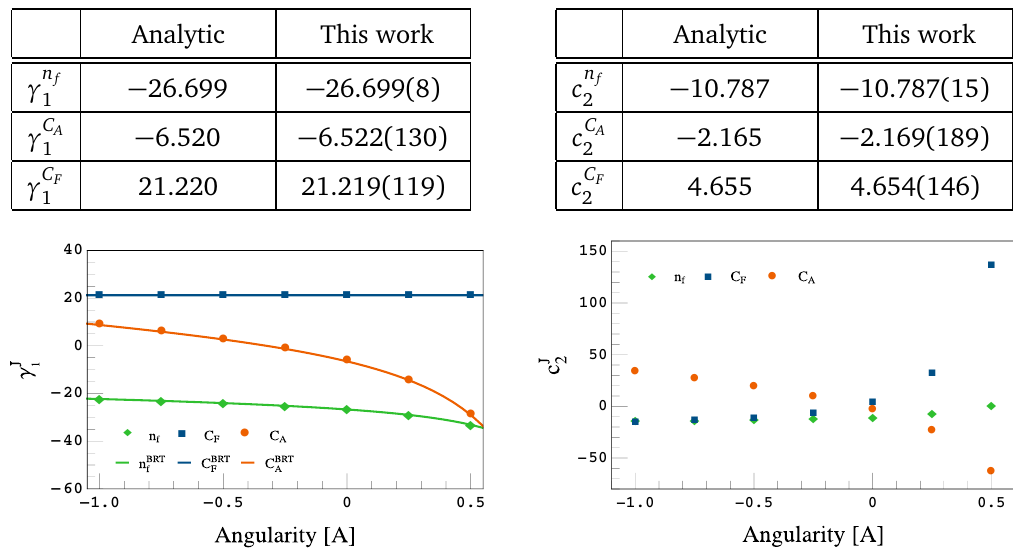
Figure 1: The two-loop non-cusp anomalous dimensions (left) are compared against the semi-analytic results (BRT) of [ 1 ] . The new c J for different angularity values. The numerical uncertainties are too small to be visible on the